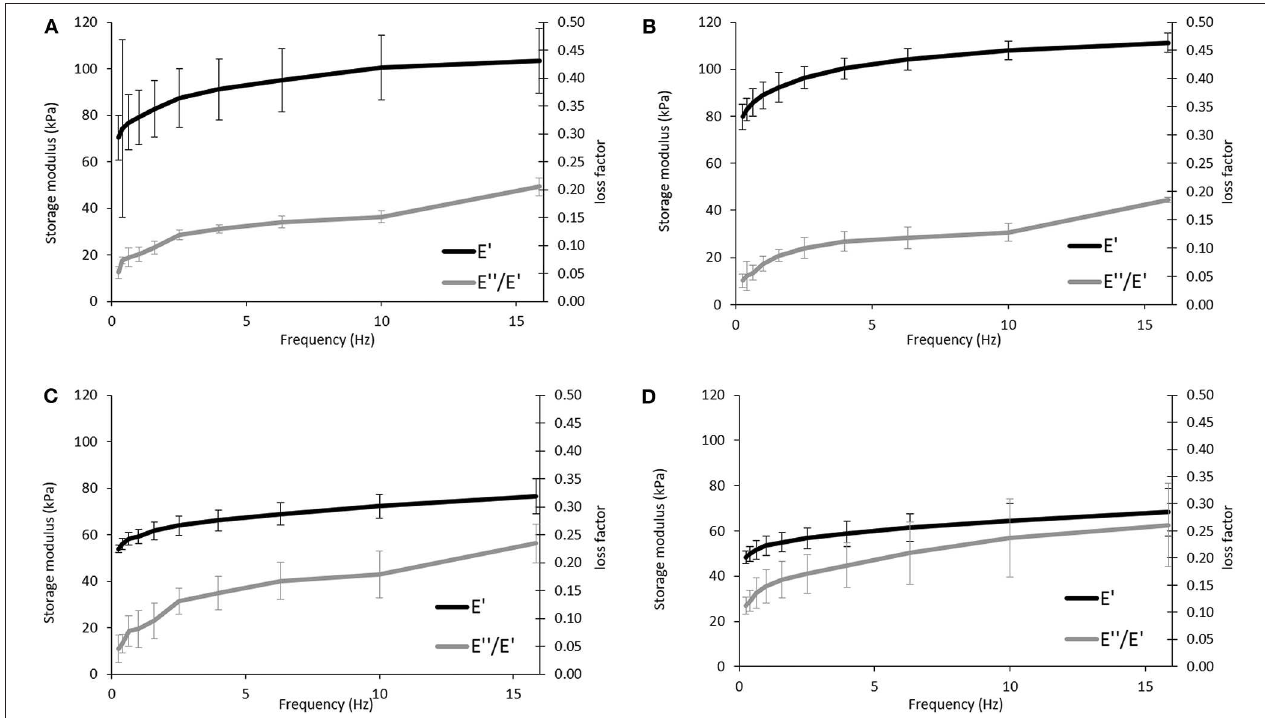
FIGURE 6 | Evaluation of the viscoelastic properties of the APC-based sponges: APC80B (A) , APC80C (B) , APC20B (C) , and APC20C (D) using DMA. Frequency scans were performed in the range 0.1–10Hz under wet conditions at 37 ◦ C.